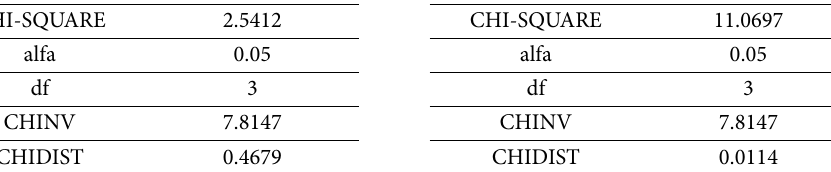
Table 3.Verification of the hypothesis H1